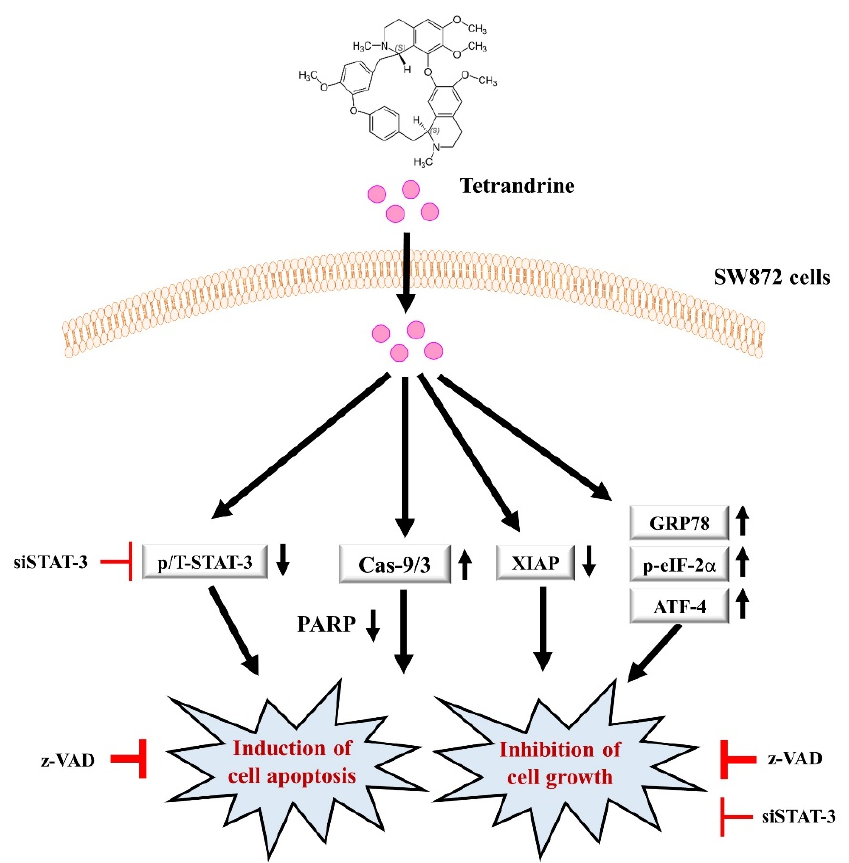
Figure 7. A diagram of the tetrandrine’s anti-survival and pro-apoptotic mechanisms (signaling pathways) in SW872 cells. Tetrandrine may activate the intrinsic (caspase-9/3-dependent) apoptotic pathway, which is crucial for the drug’s apoptosis-inducing and growth-suppressive effects on SW872 cells. In addition, tetrandrine may further inhibit STAT-3 and down-regulate XIAP, which